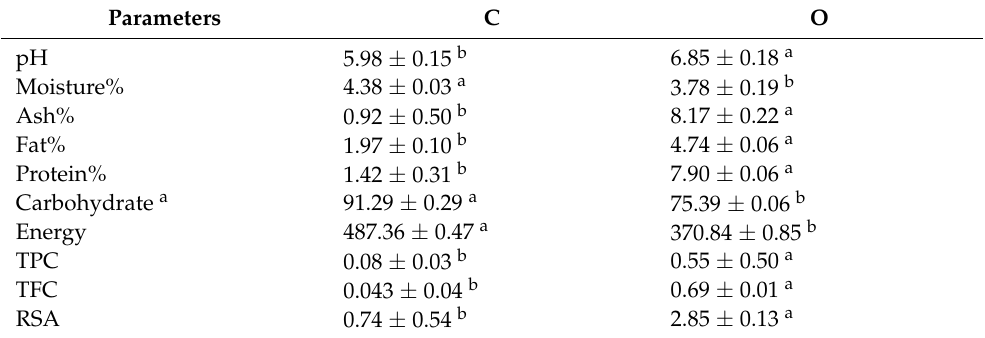
Figure 6. The two-dimensional diagrams of the contour areas ( A ), desirability ramp ( B ). Table 5. Chemical composition and physical properties of the optimal (O) and control sample